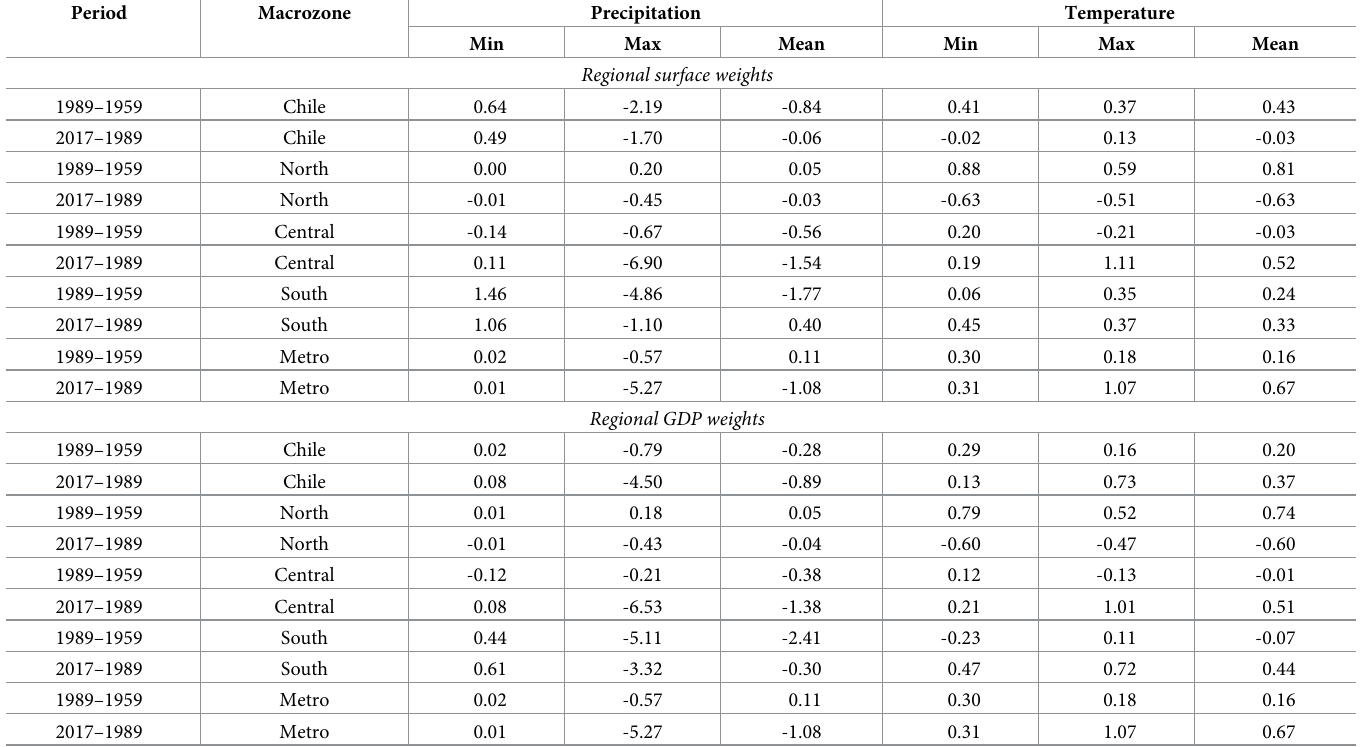
Table 3. Changes yearly minimum, maximum and mean in precipitation and